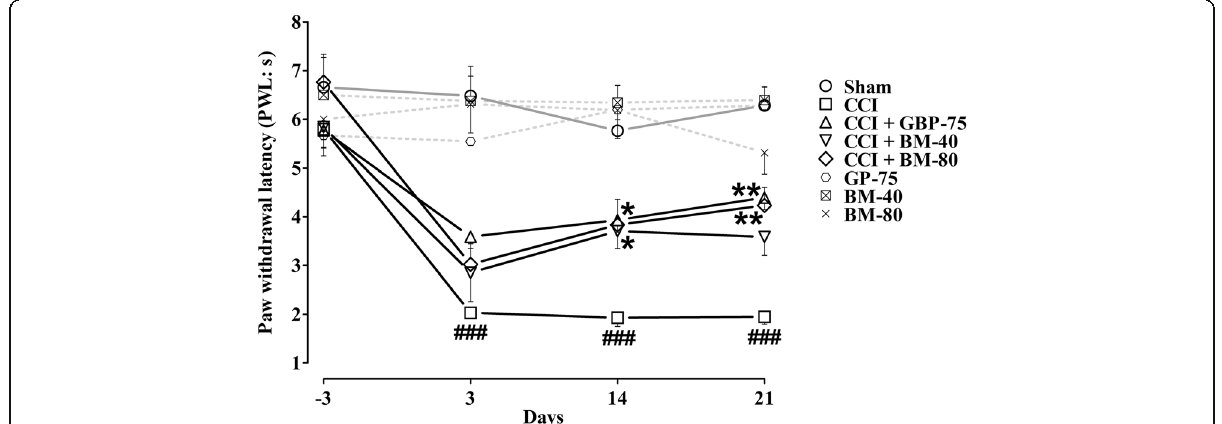
Fig. 4 Effect of Bacopa monnieri methanolic extract (BM-40 and BM-80) and gabapentin (GBP-75) on the maintenance of chronic constriction injury (CCI) induced heat hyperalgesia (shortened paw withdrawal latency to heat stimulus; PWL in s). Values expressed as mean ± S.E.M. ### P < 0.001 compared to sham-operated animals, * P < 0.05, ** P < 0.01 compared to CCI-operated untreated animals, two-way repeated measures ANOVA followed by post hoc Bonferroni analysis. n = 6 rats per